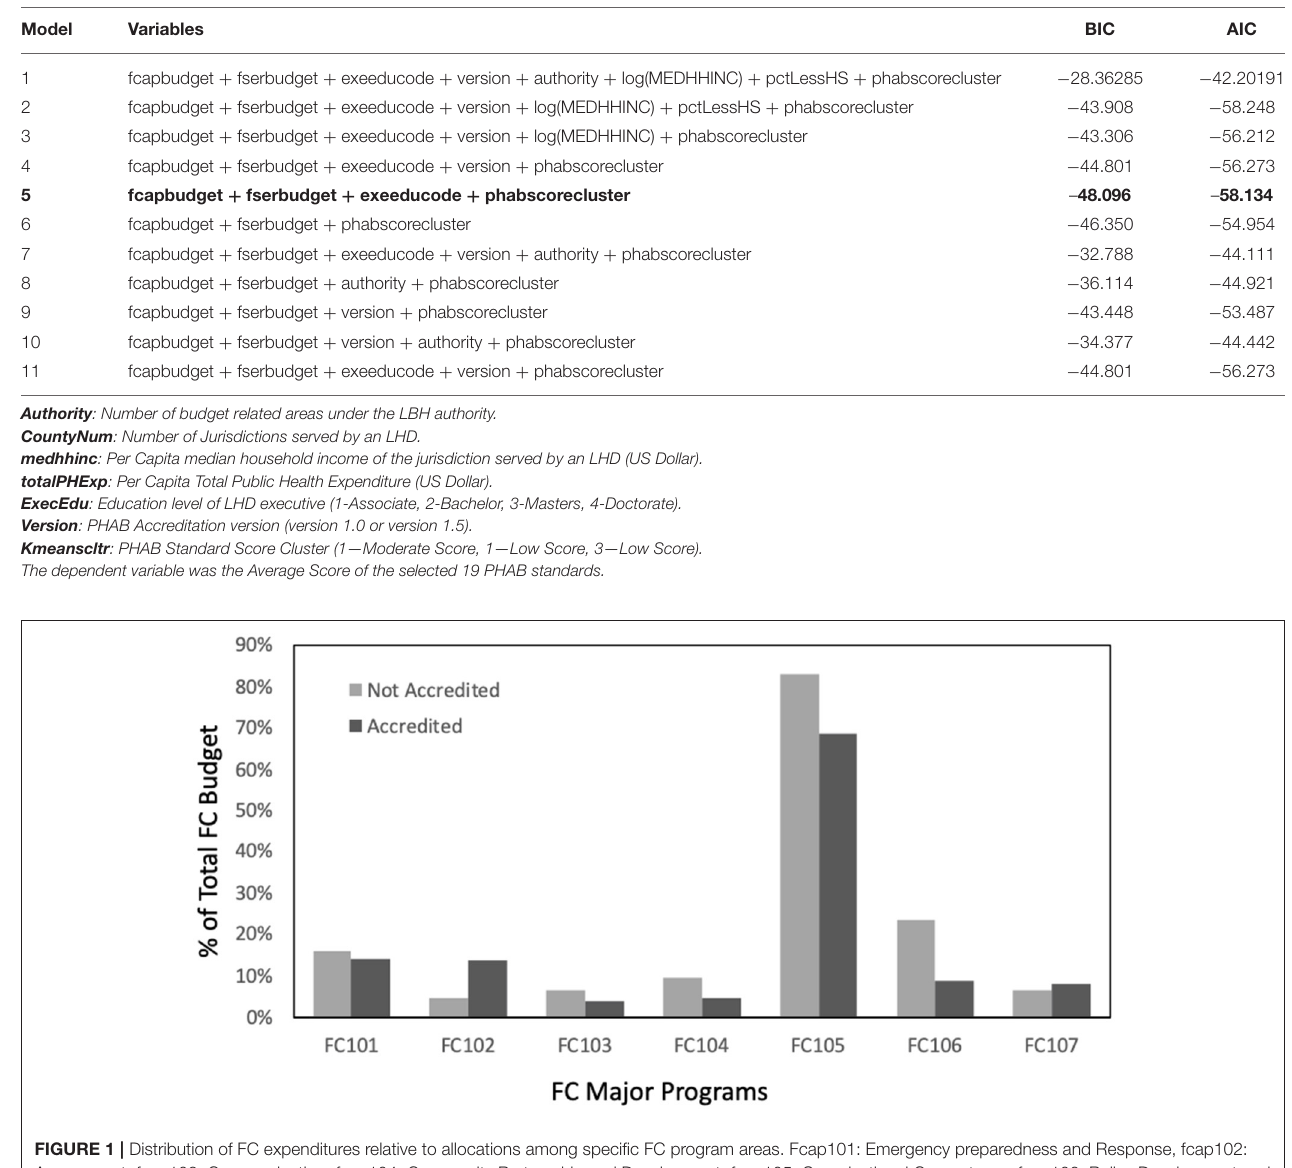
FIGURE 1 | Distribution of FC expenditures relative to allocations among specific FC program areas. Fcap101: Emergency preparedness and Response, fcap102: Assessment, fcap103: Communication, fcap104: Community Partnership and Development, fcap105: Organizational Competency, fcap106: Policy Development and Support, fcap107: Other